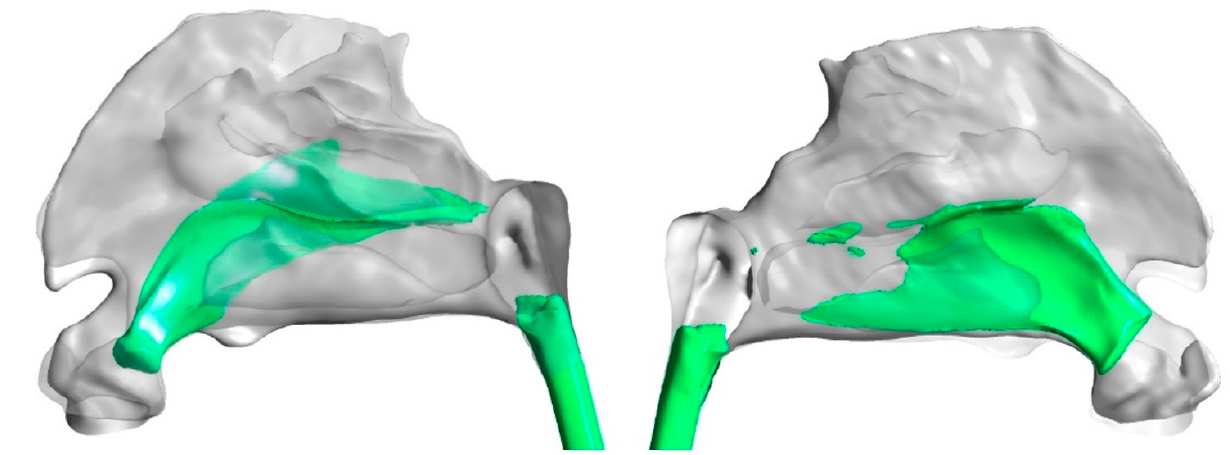
Figure 10. Isotropic velocity surface pattern in both chambers, where the green regions show the airflow with velocity exceeding 3.5 m/s in the left chamber ( left hand side pattern ) and the right chamber ( right hand side pattern ).